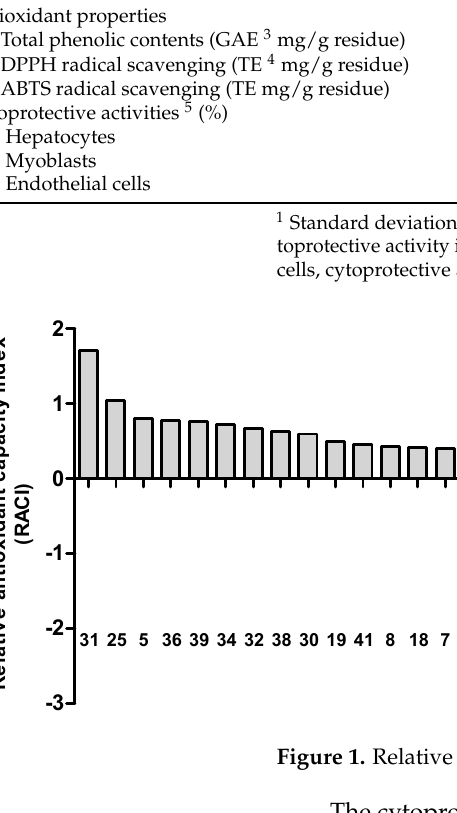
Table 2. Descriptive statistics of antioxidant properties and cytoprotective activities in whole wheat extracts (WWE).